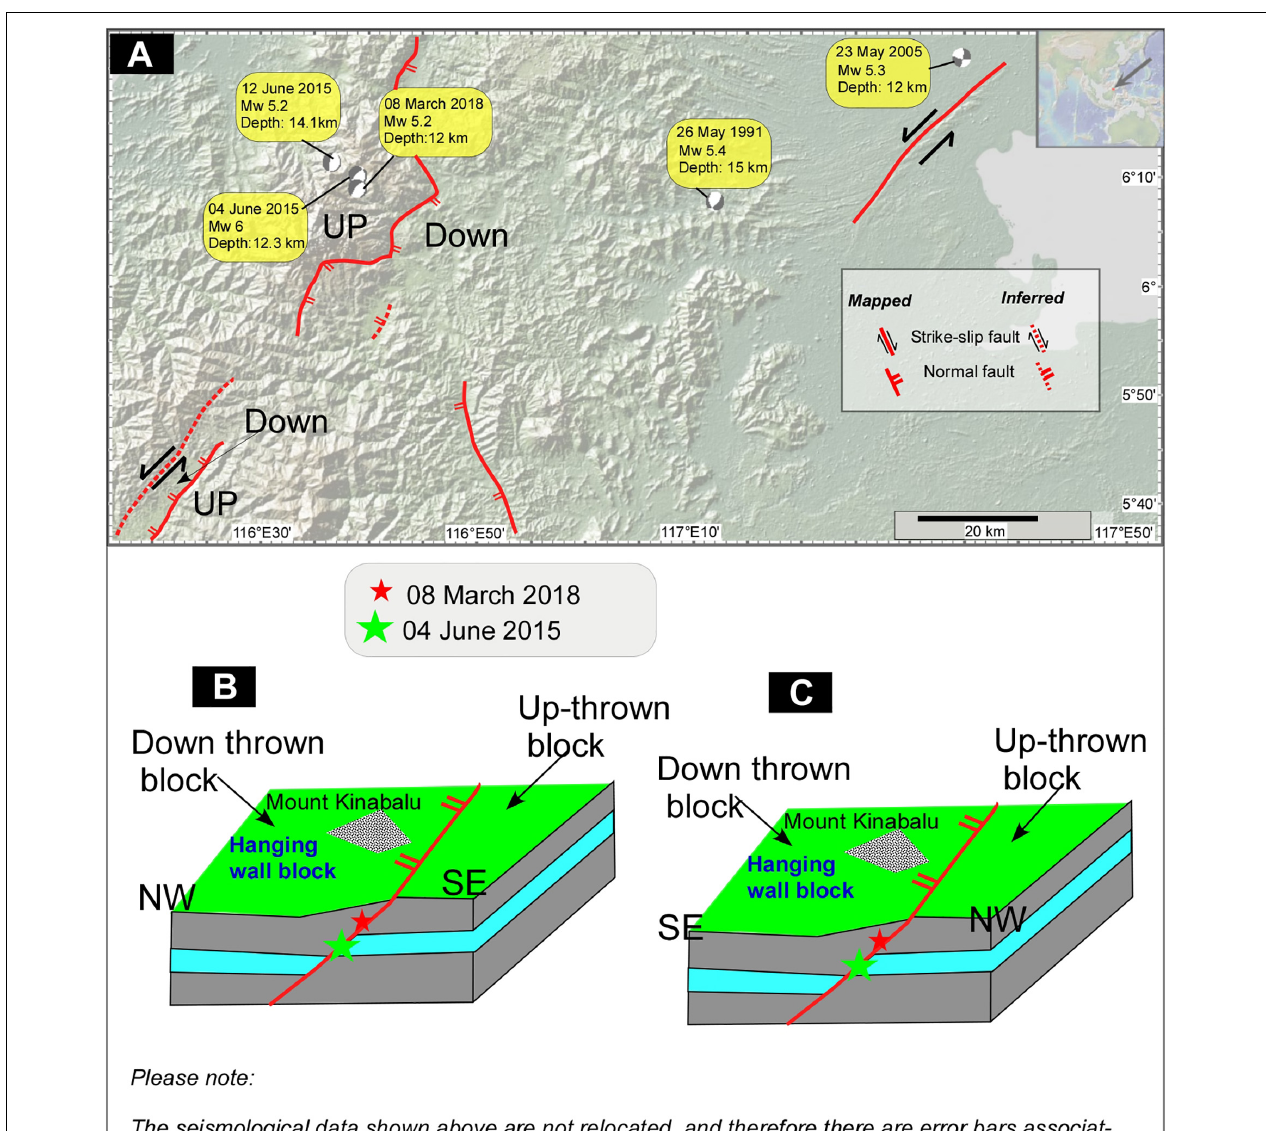
FIGURE 3 | Topographic and structural map of NW Borneo shows the locations of Centroid-Moment-Tensor solutions and the traces of active faults (A) . The figure is created using the GeoMap App. software, which uses data from the Global Centroid-Moment-Tensor Project since the year 1976 until now. The most of the mapped active faults are after Shah (2015) and Shah et al. (2018b). The cartoon (B) shows the structurally most feasible fault plane on which the June 2015 and March 2018 earthquake events might have originated. The SE dipping fault plane is not fitting well with the fault parameters and the field data (C) .